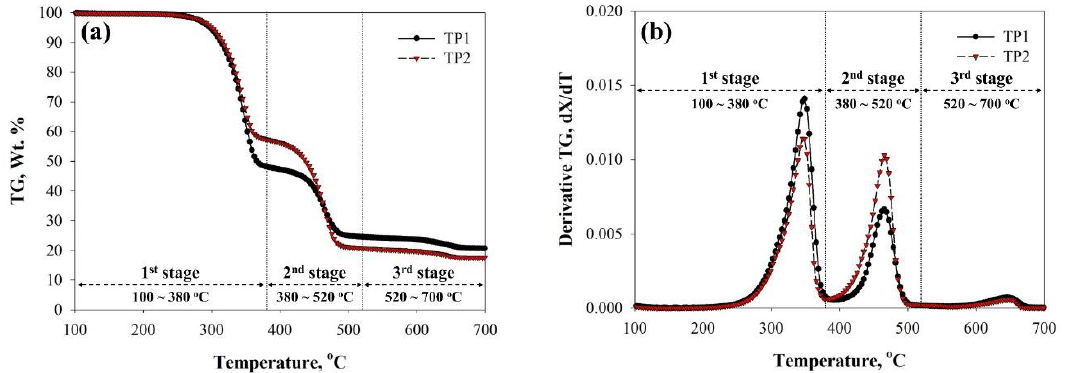
Figure 1. ( a ) TG and ( b ) derivative TG (DTG) curves of TPs obtained from their non-isothermal pyrolysis at a heating rate of 10 °C/min.